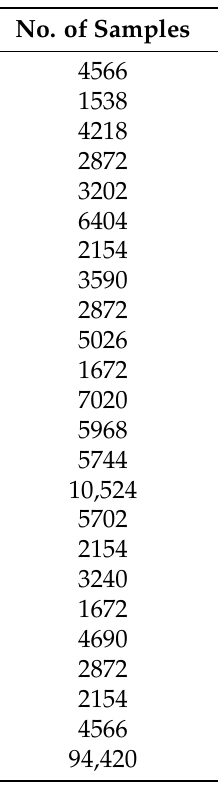
Table 1. Detailed information on the CHB-MIT Scalp EEG database and the data used in this study. Sex: Female (F), Male (M). Seizure type: simple partial seizure (SP), complex partial seizure (CP) and generalized tonic-clonic seizure (GTC). No. of channels: Number of channels included in this databse. No. of recordings: Number of edf files. No. of seizures